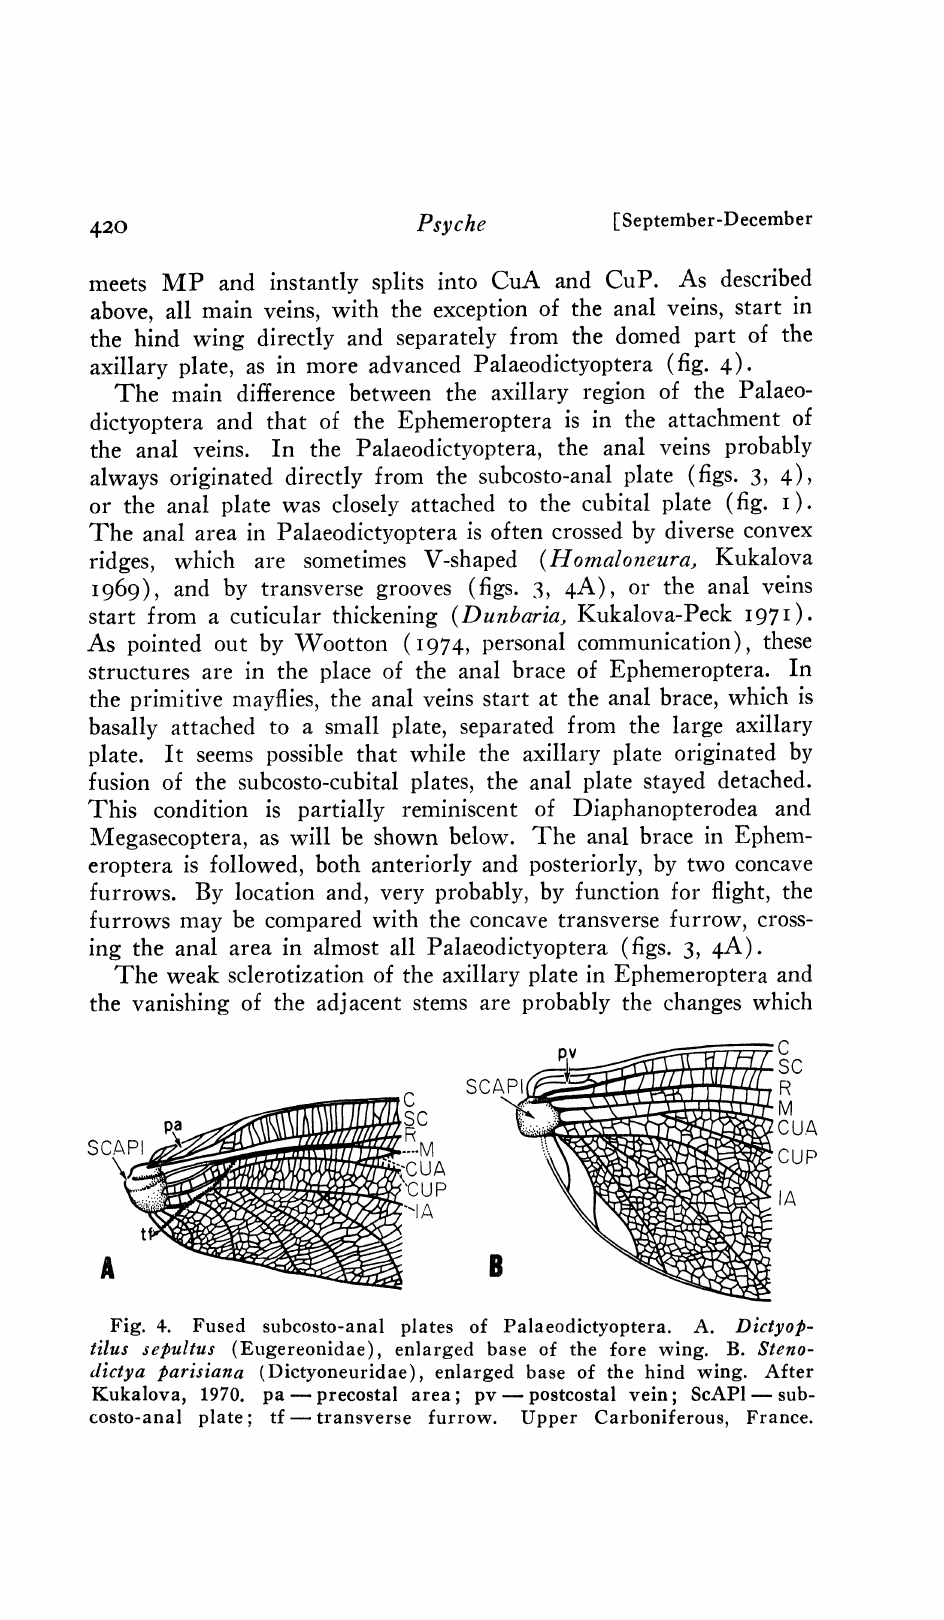
Fig. 4. Fused subcosto-anal plates of alaeodictyoptera. A. Dittyo/- tilus selmltus (Eugereonidae), enlarged base of the fore wing. B. dictya parisiana (Dictyoneuridae), enlarged base of the hind wing. After Kukalova, 1970. pa--precostal area; pv---postcostal vein; ScAPlmsub- costo-anal plate; tfmtransverse furrow. Upper Carboniferous,